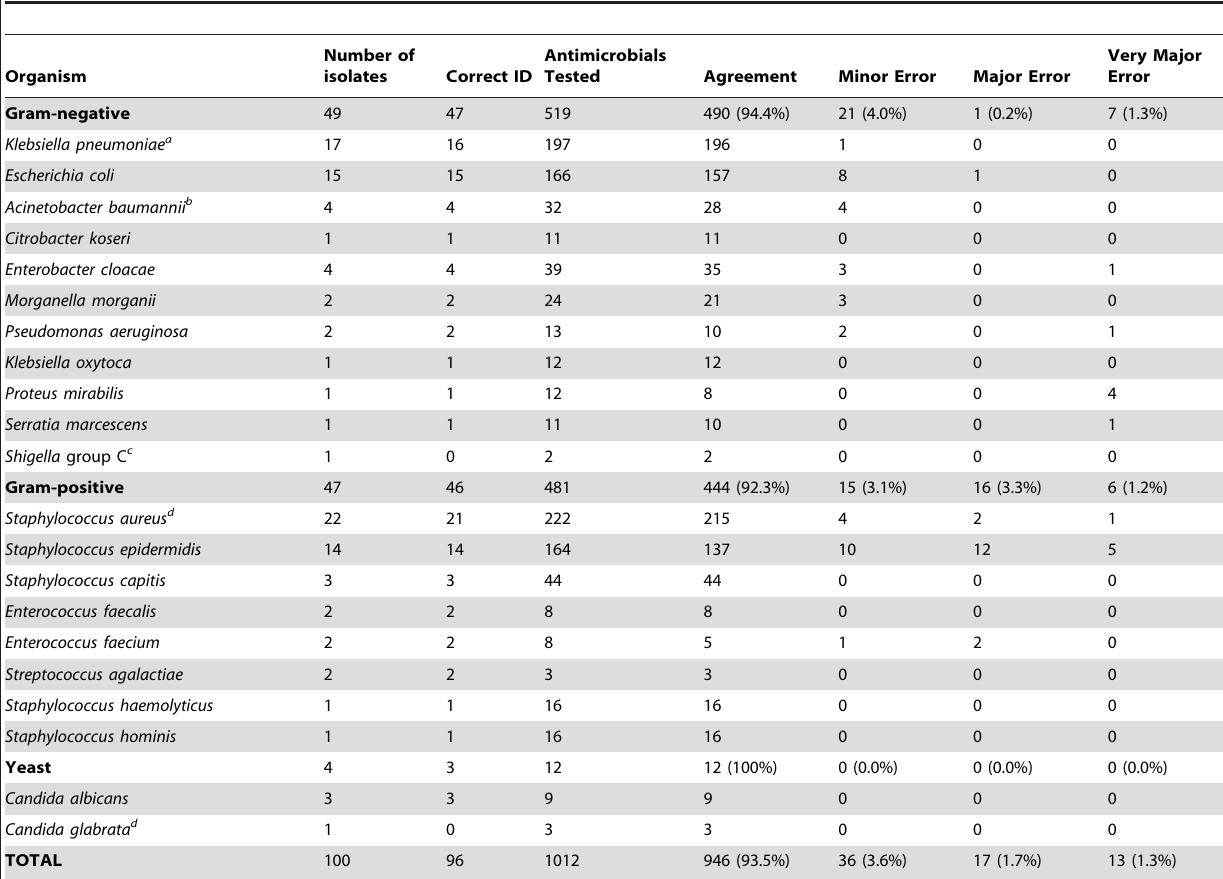
Table 1. Susceptibility testing of bacteria from positive blood culture bottles by using a Lysis-Filtration Method, MALDI-TOF Mass Spectrum Analysis with SARAMIS Database, and the VITEK H 2